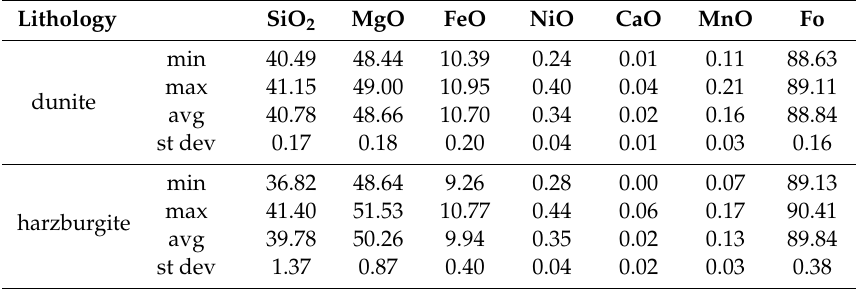
Table 2. Representative analyses of olivine from dunite and harzburgite with max, min and average ranging value of olivine for some oxides and Fo number in BA1B and BA3A